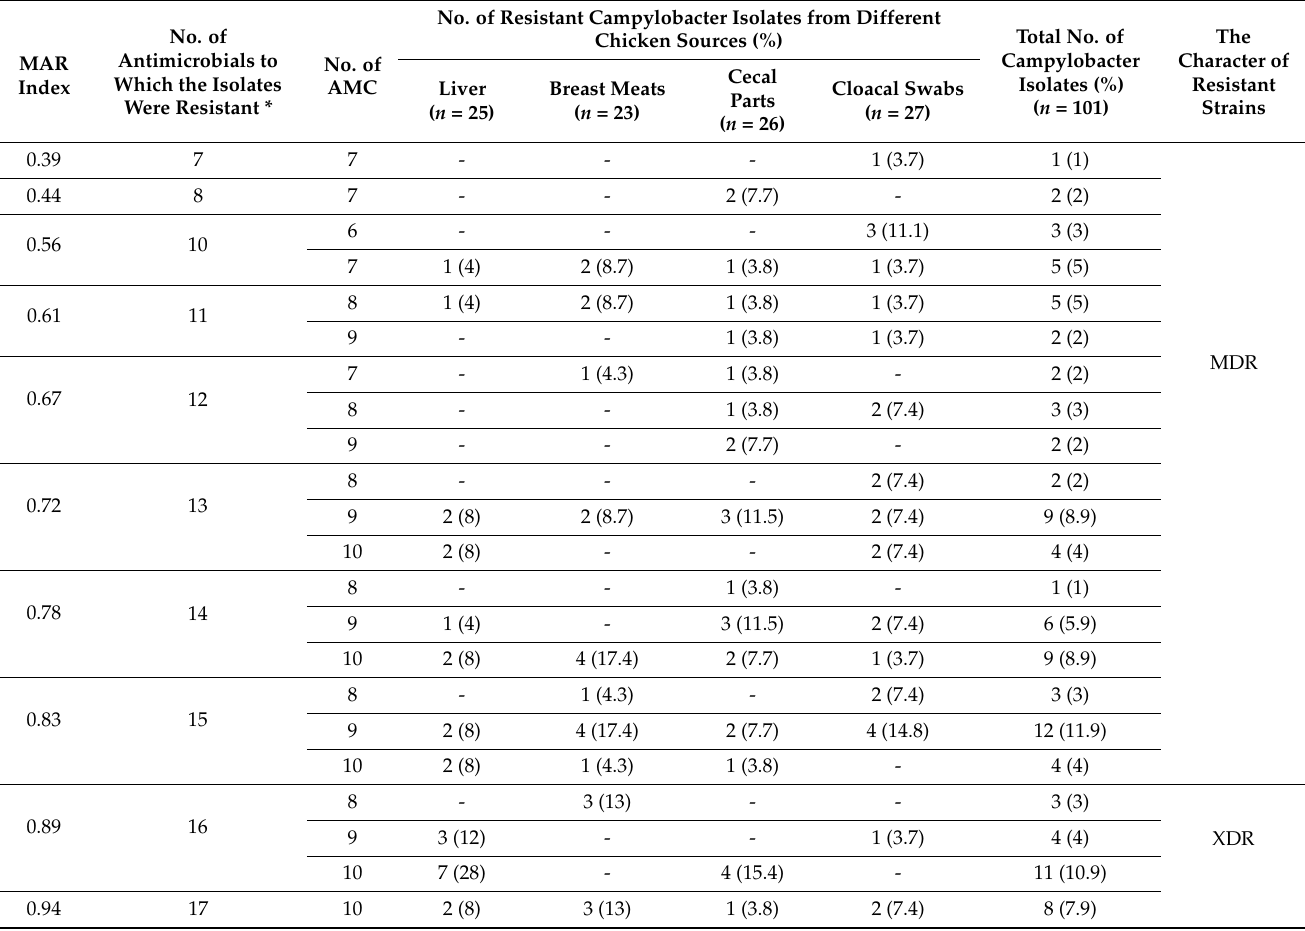
Table 6. Multiple antibiotic resistance indices and the frequency of resistance of the campylobacter isolates from different chicken